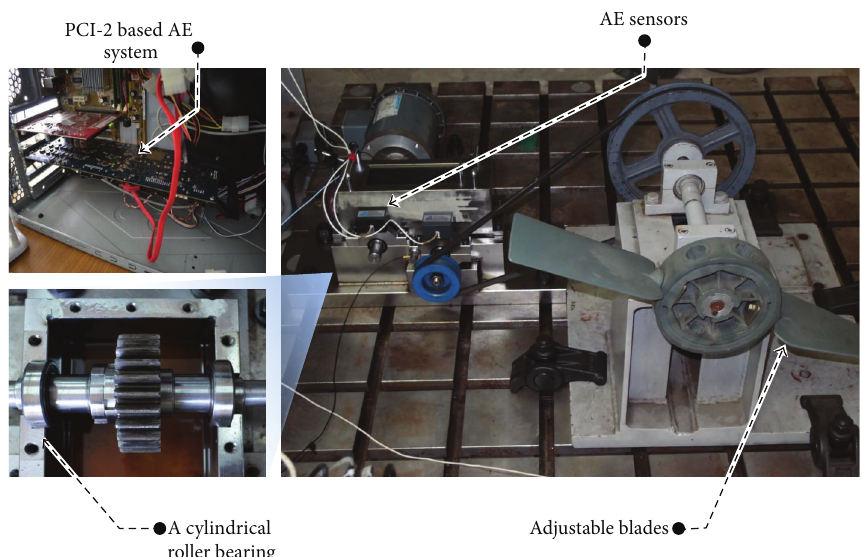
Figure 4: Experimental test rig for fault diagnosis of rolling element bearings